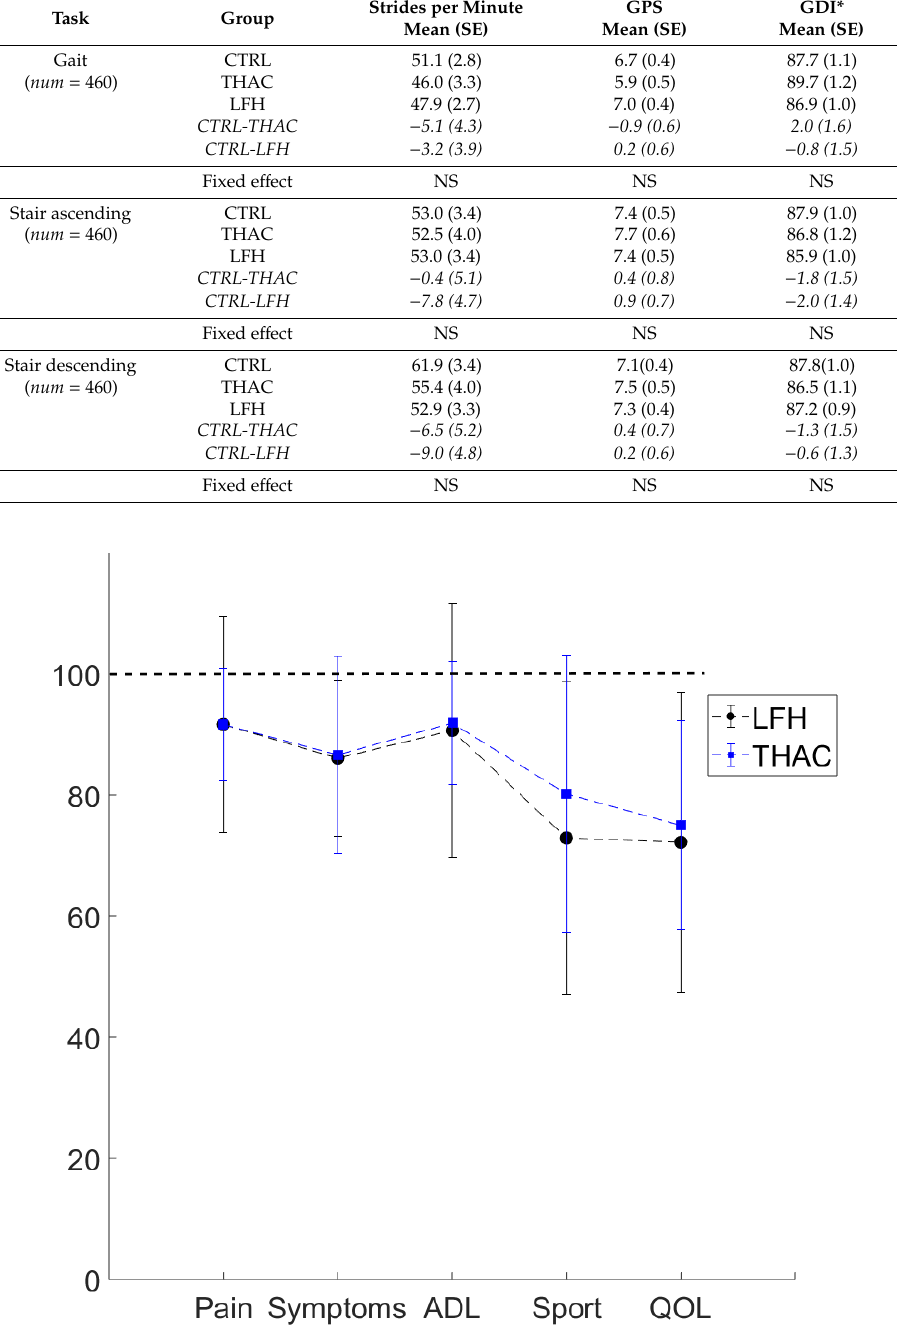
Figure 1. Hip dysfunction and Osteoarthritis Outcome Score (HOOS) profiles for the conventional THA prosthesis group (THAC) and large femoral head (LFH) prosthesis group. 100 indicates normal function and 0 indicates severe problems related to hip function. The five categories analyzed were Pain, Symptoms, Activities of daily living (ADL), Sport and recreation function (Sport) and Hip-related quality of life (QOL).